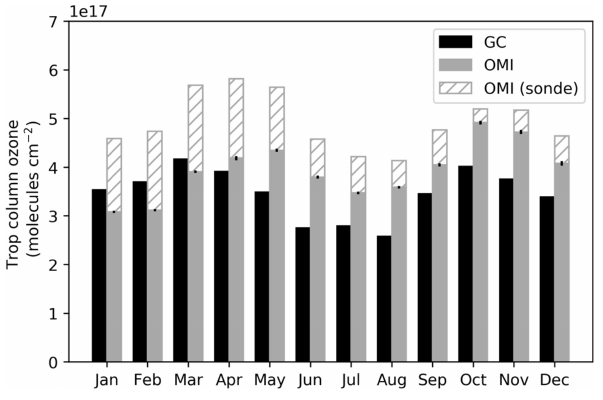
Figure 5. Time series of GEOS-Chem model and OMI monthly mean tropospheric ozone column (molec.cm − 2 ) across Southeast Asia in 2014. Model results for the full time series are from the 2 ◦ × 2.5 ◦ global simulation. Error bars shown for OMI are the stan- dard errors in the mean as an indication of random error. Also shown are OMI values adjusted for bias estimates with respect to an ozonesonde ensemble as an indication of the systematic error range.